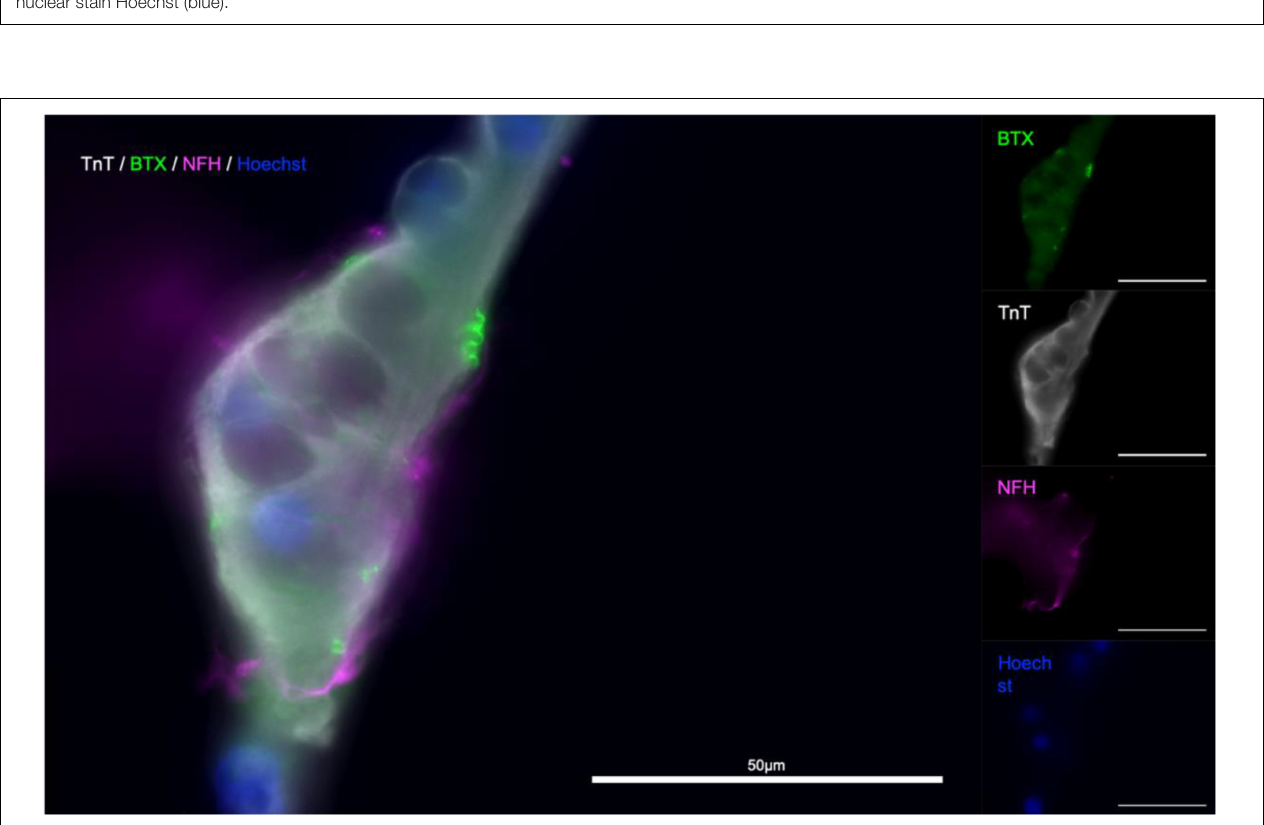
FIGURE 6 | α -Bungarotoxin staining indicates presence of functional NMJs. Troponin T (TnT, gray), α -Bungarotoxin (BTX, green), and Neurofilament-heavy (NF-H, magenta), nuclear stain Hoechst (blue). Merged image (left).